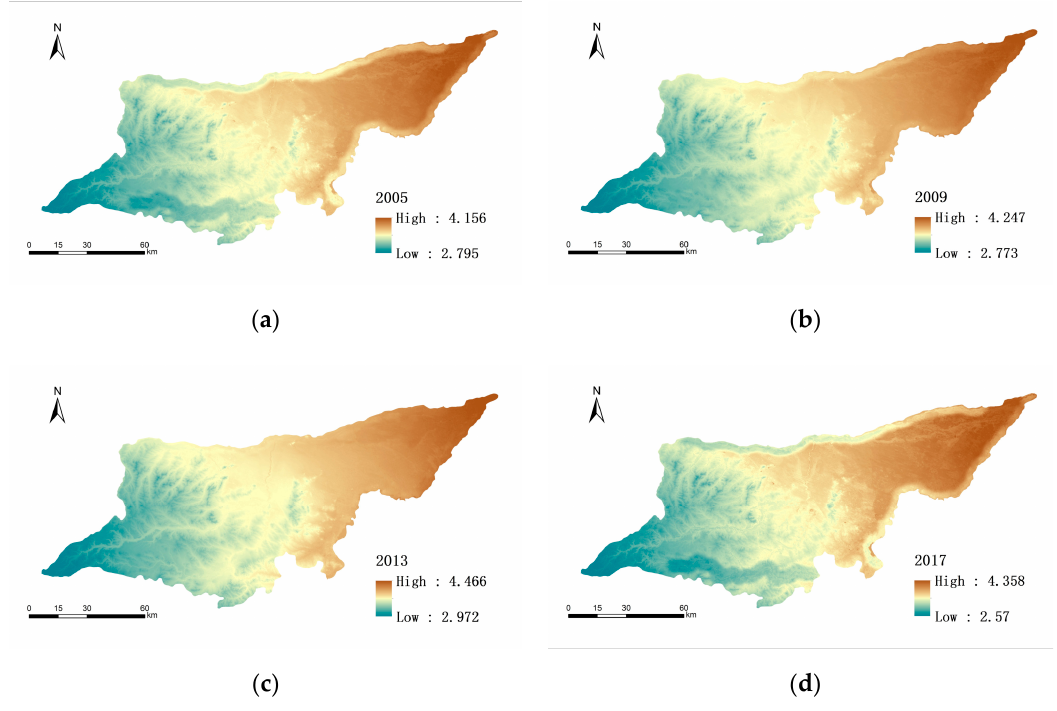
Figure 6. Cokriging interpolation result in ( a ) 2005, ( b ) 2009, ( c ) 2013, ( d ) 2017.